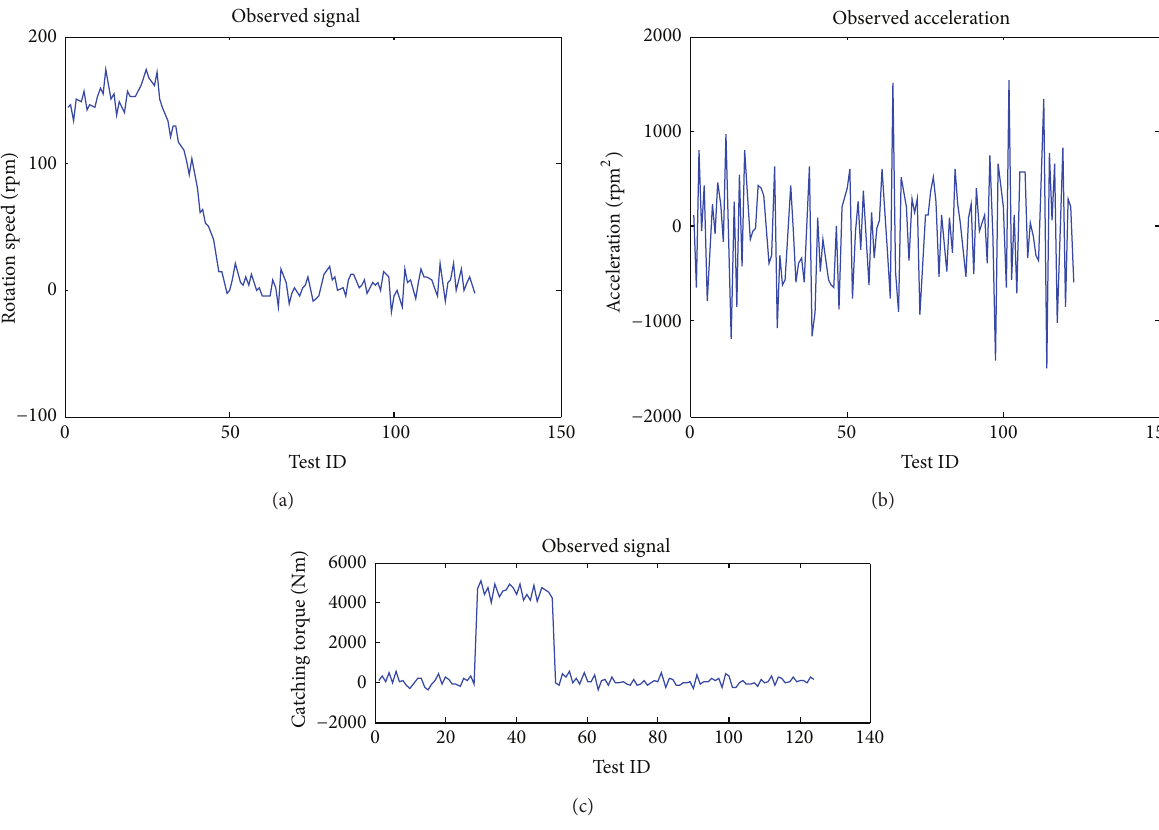
Figure 2: Observed signal of an antifalling safety